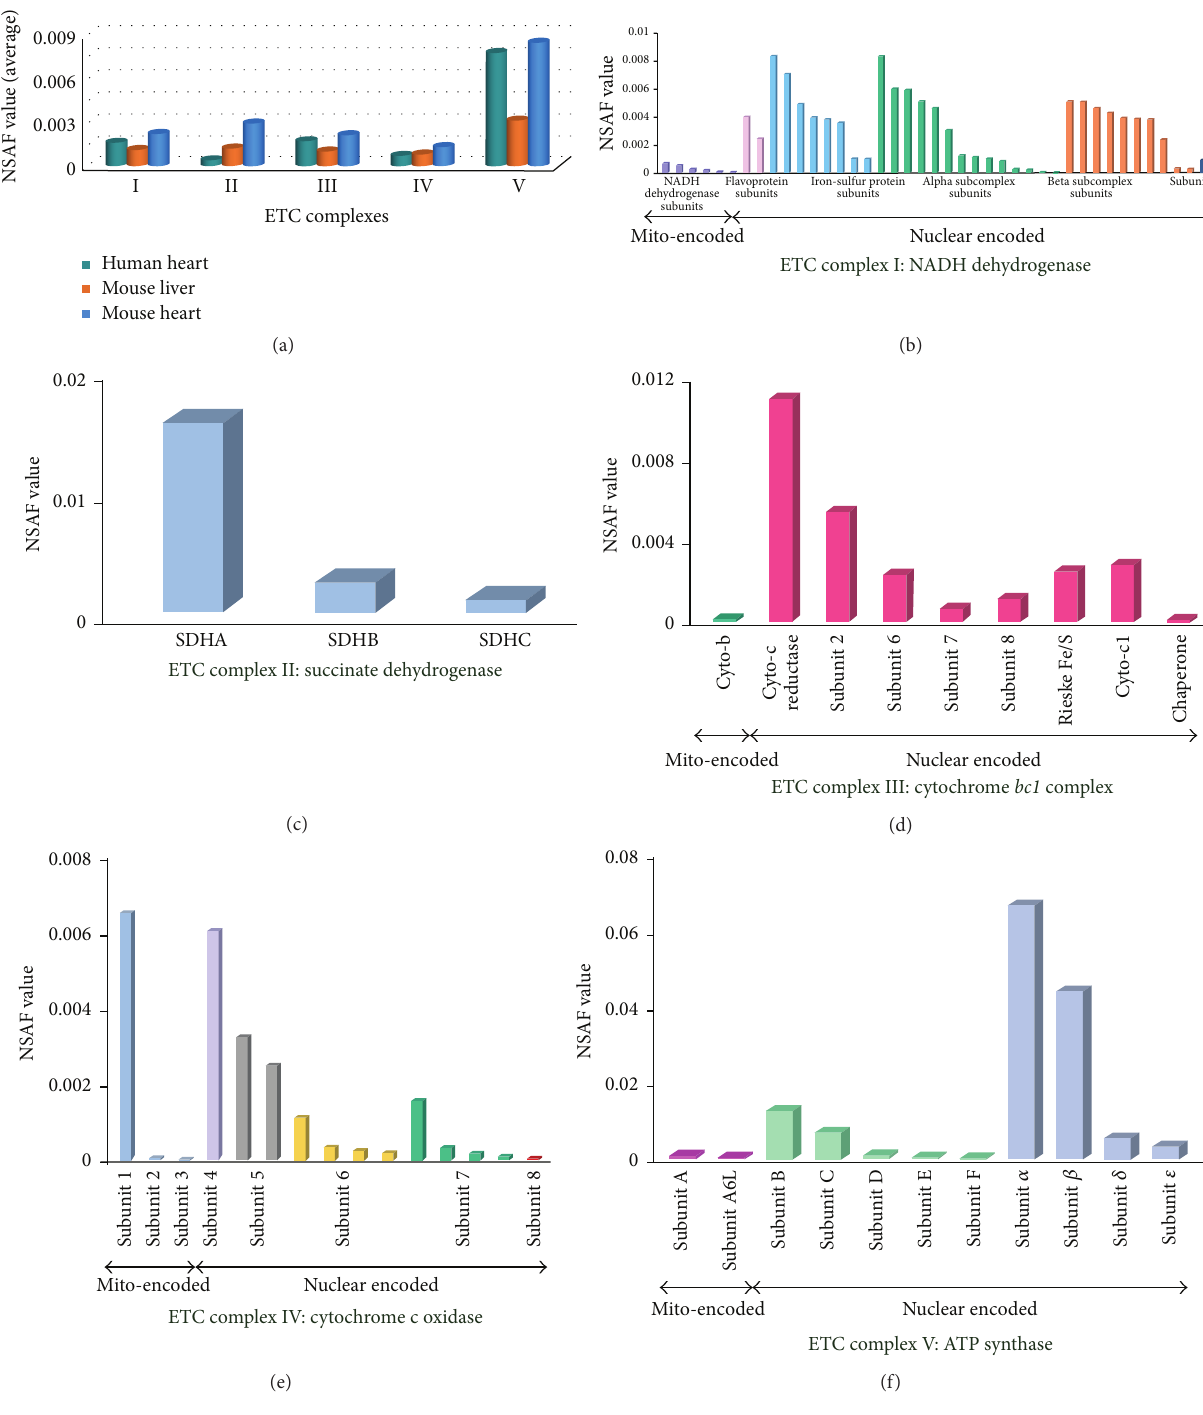
Figure 6: The quantitative analysis of ETC complex subunits. Three groups of proteins with different complexes were compared with averaged NSAF of each ETC complex. (a) shows quantitative abundance of all five ETC complexes; Complex I to Complex IV displayed very similar level of abundances. In comparison, Complex V appeared to be in higher abundance, approximately 3-fold more than others. (b) shows quantitative analysis of proteins in Complex I and proteins were encoded by mitochondrial genome or nuclear genome, respectively; (c) shows quantitative analysis of proteins in Complex II; (d) shows quantitative analysis of proteins in Complex III and proteins were encoded by mitochondrial genome or nuclear genome, respectively; (e) shows quantitative analysis of proteins in Complex IV and proteins were encoded by mitochondrial genome or nuclear genome, respectively; (f) shows quantitative analysis of proteins in Complex V and proteins were encoded by mitochondrial genome or nuclear genome,